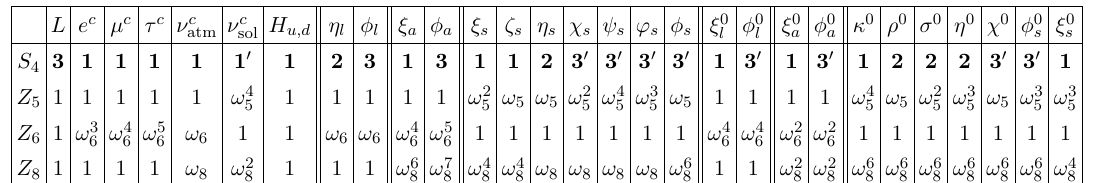
L e c (cid:22) c (cid:28) c (cid:23) c